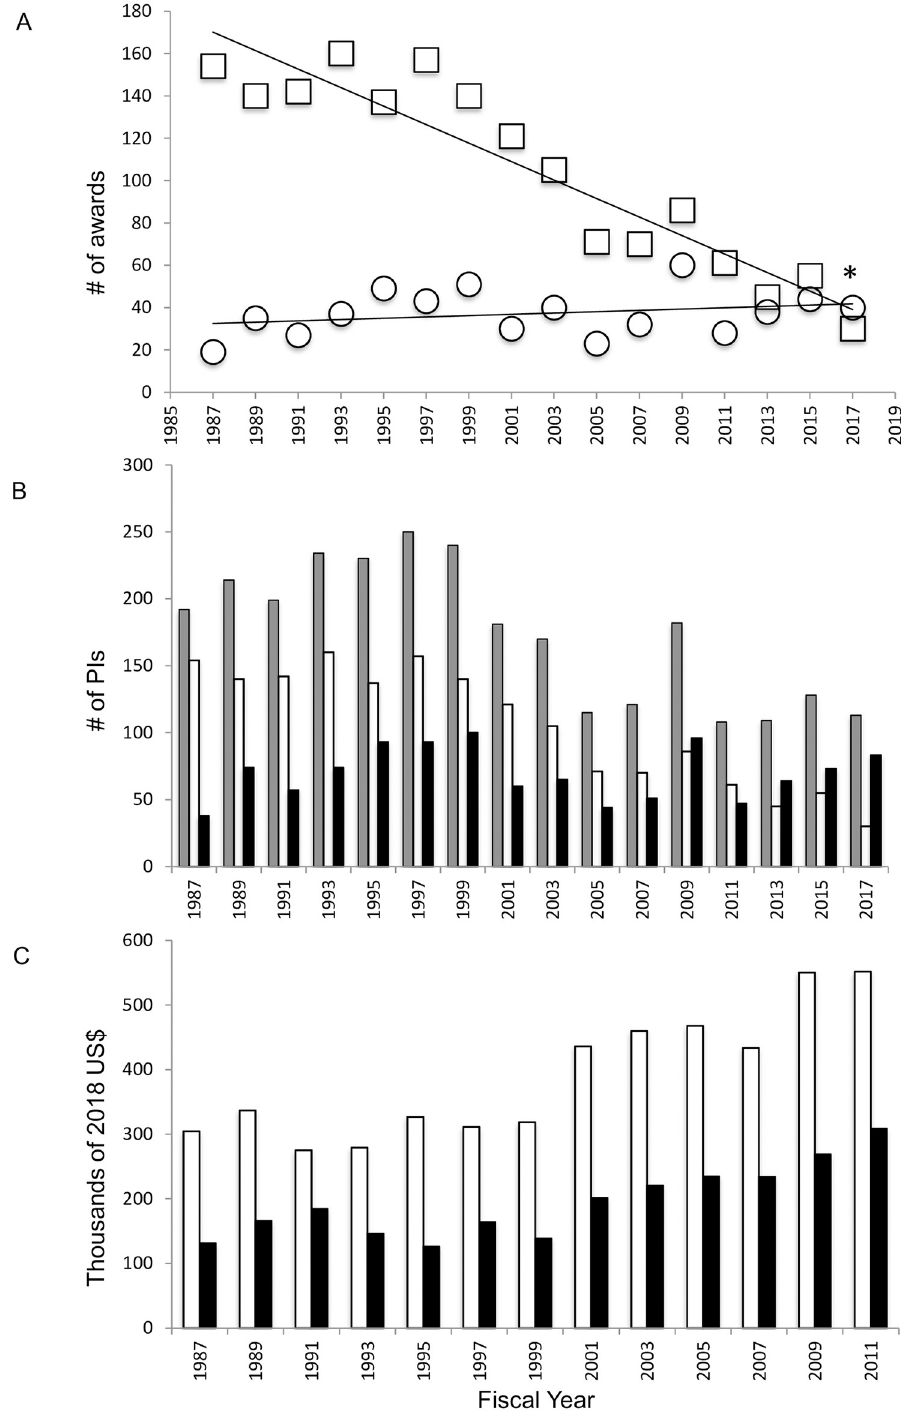
Fig 3. Grant funding by NSF NBR programs for collaborative and sole PI projects. A. Sole PI (squares) and collaborative (circles) NBR awards funded from FY1987- FY2017. B. Total PIs funded (grey), sole PIs (white)